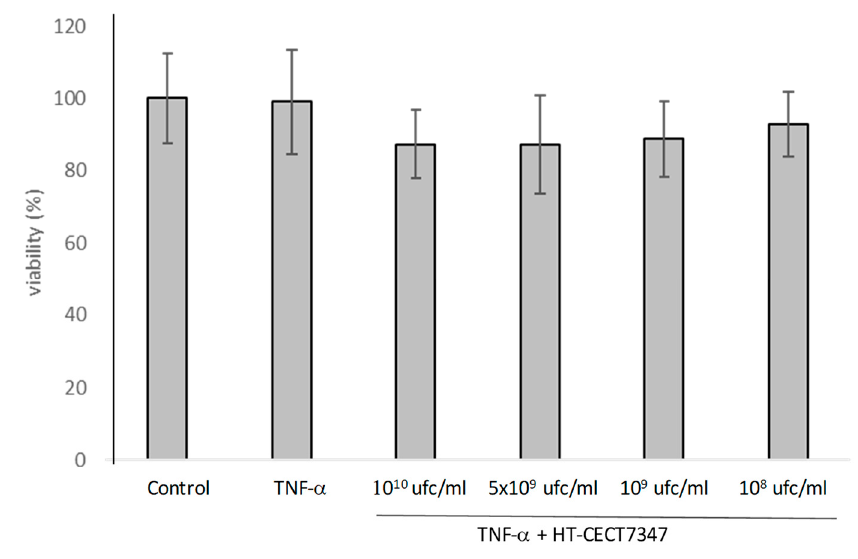
Figure A1. Maintenance of cell viability upon TNF- α stimulation in the different samples in which IL-8 production has been quantified, corresponding to Figure 4 in the main text.